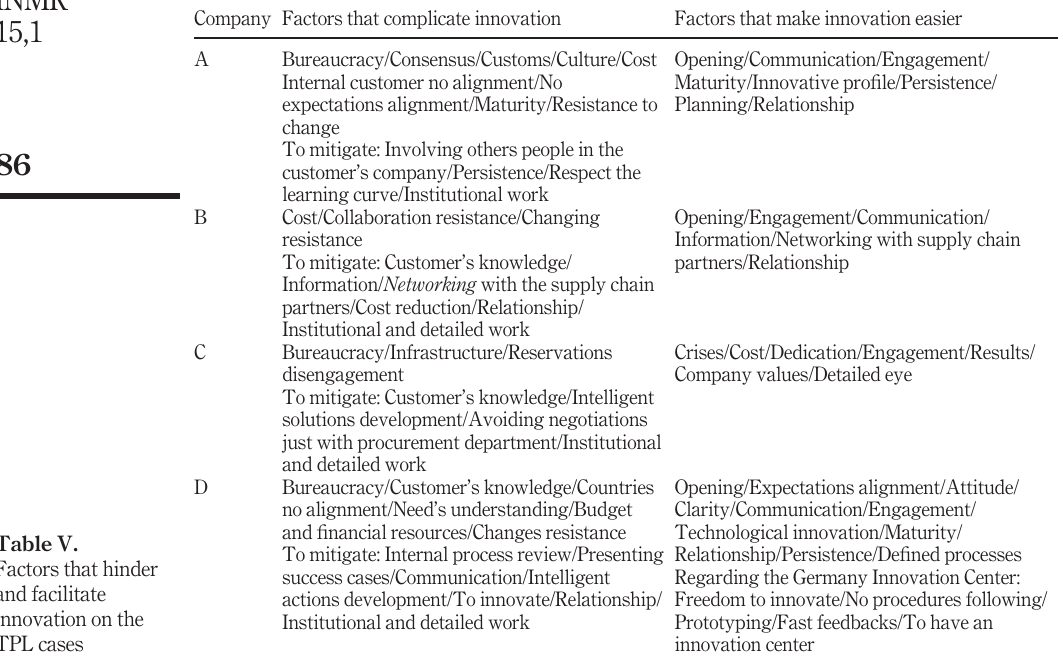
Table V. Factors that hinder and facilitate innovation on the TPL